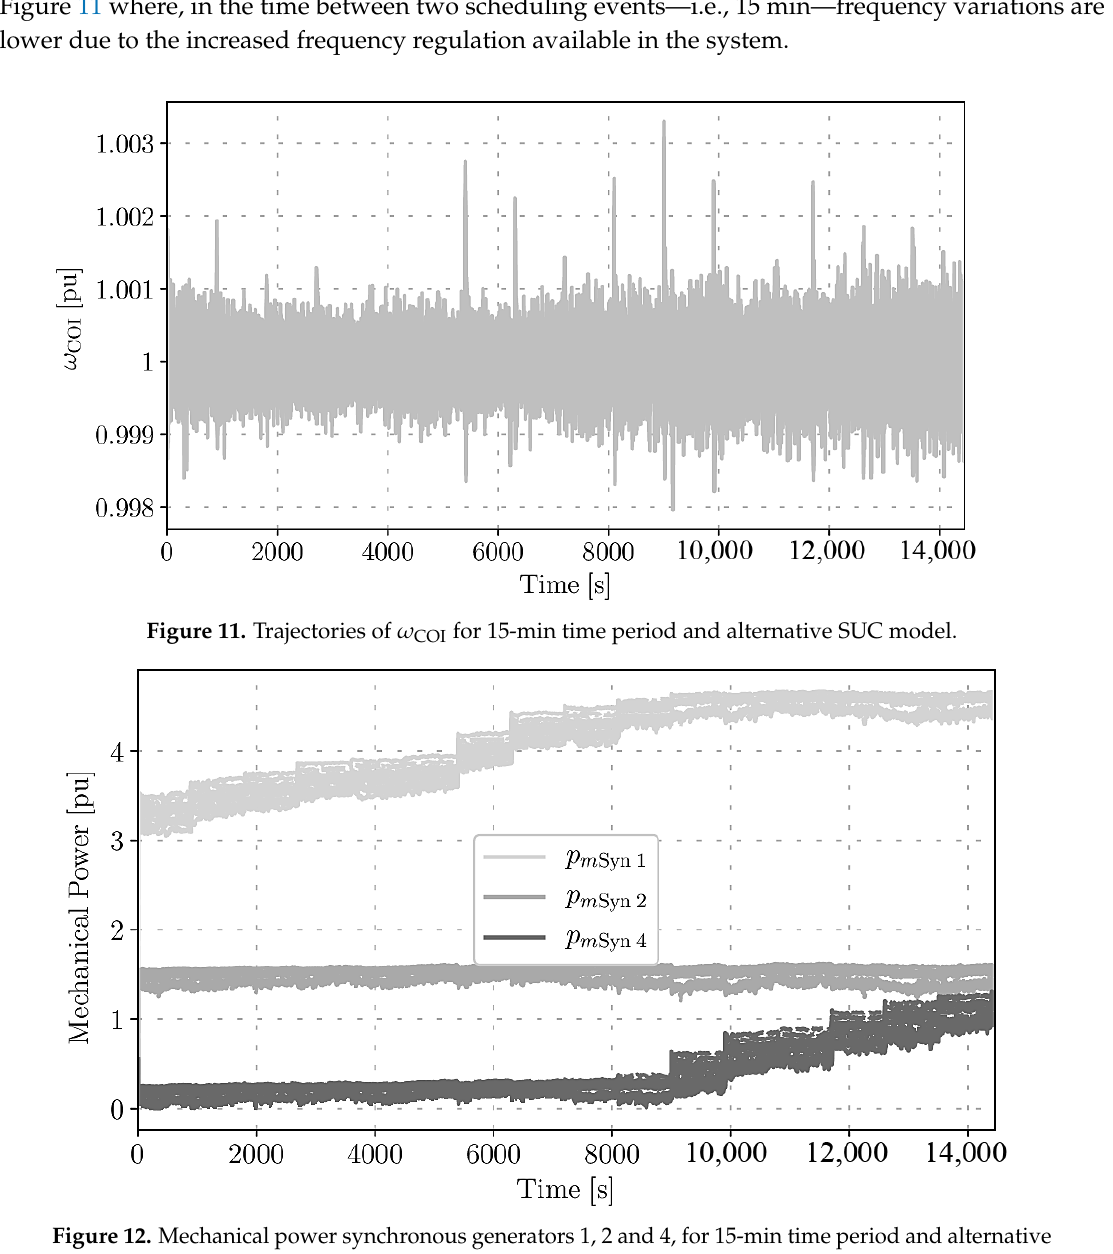
Figure 12. Mechanical power synchronous generators 1, 2 and 4, for 15-min time period and alternative SUC